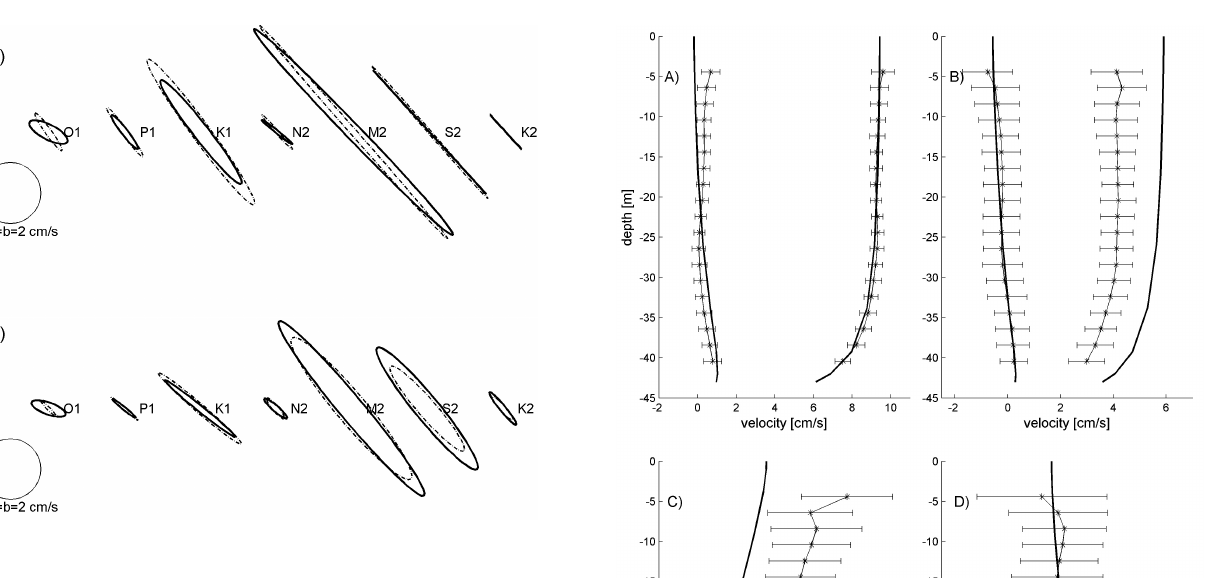
Fig. 12. Tidal ellipses for seven constituents at the J station: (A) surface – 8.5m, (B) bottom – 40.5m depth, based on observations (bold solid) and model results (dashed).